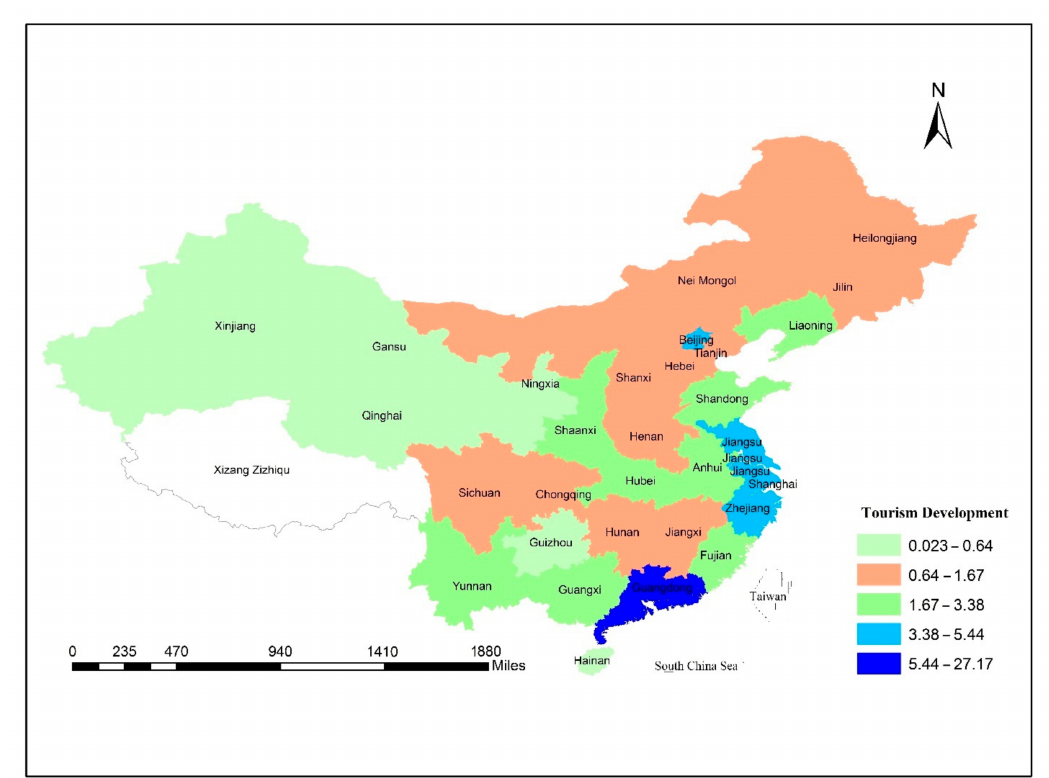
Figure 4. Spatial distribution of the percentage of overseas arrivals across provinces of China, 2001–2018.